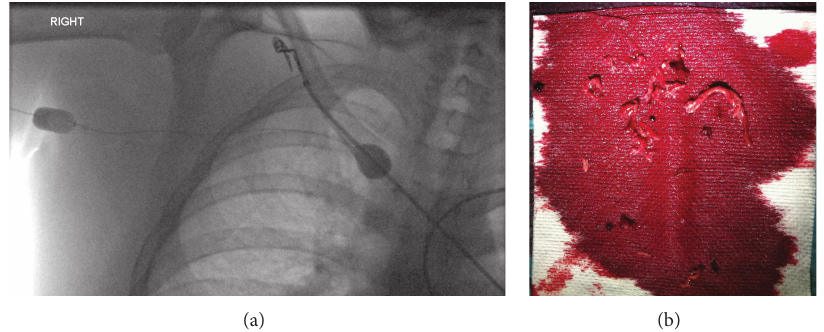
Figure 1: (a) Fluoroscopic image showing the distal compliant balloon of the Trellis-8 device inflated in the brachiocephalic vein and the proximal balloon inflated in the subclavian vein. (b) Aspirated thrombus following PMT. There is a mix of fresh and chronic